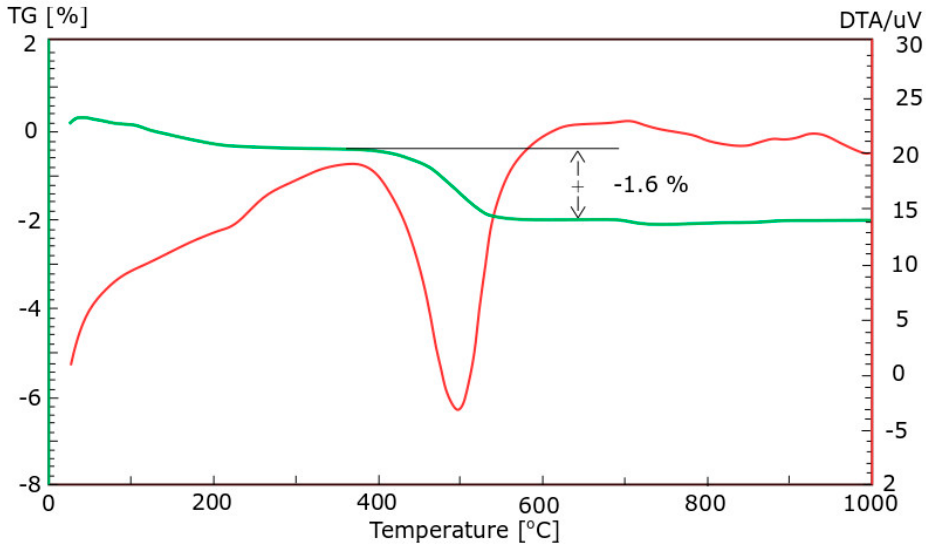
Figure 2. The di ff erential thermal analysis (DTA) pattern of CFA batch A. Figure 2. The differential thermal analysis (DTA) pattern of CFA batch A. Figure 2. The differential thermal analysis (DTA) pattern of CFA batch A.